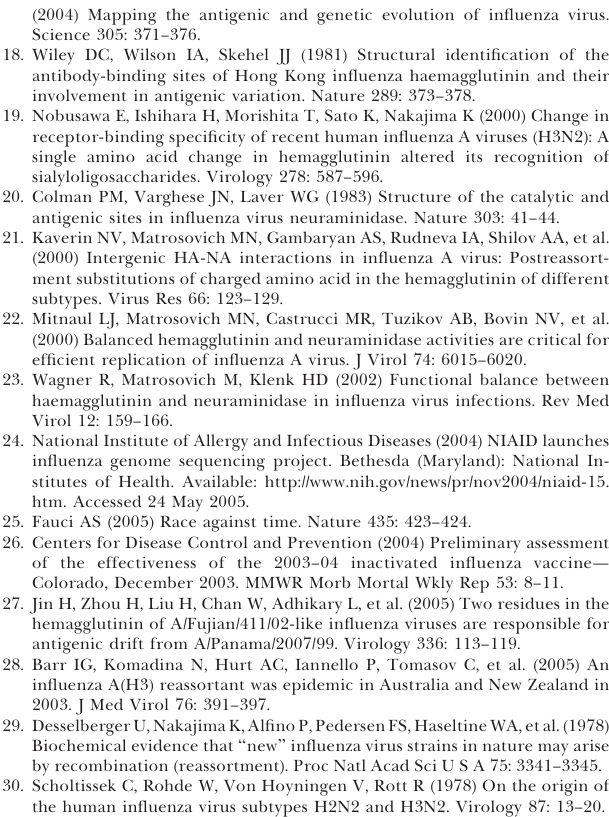
Figure S1. Phylogenetic Trees of New York State and Background H3N2 Strains Inferred from the Core Genes Maximum likelihood phylogenetic trees depicting the evolutionary relationships of the remaining six segments (major coding regions only) from the H3N2 influenza A viruses sampled in New York State during the period 1999–2004 (unique sequences only) and the ‘‘ background ’’ viruses taken from GenBank or the Los Alamos Influenza Sequence Database. All trees are mid-point rooted for purposes of clarity only, and all horizontal branch lengths are drawn to scale. Bootstrap values are shown for clades A, B, and C. Colors are as in Figure 1.